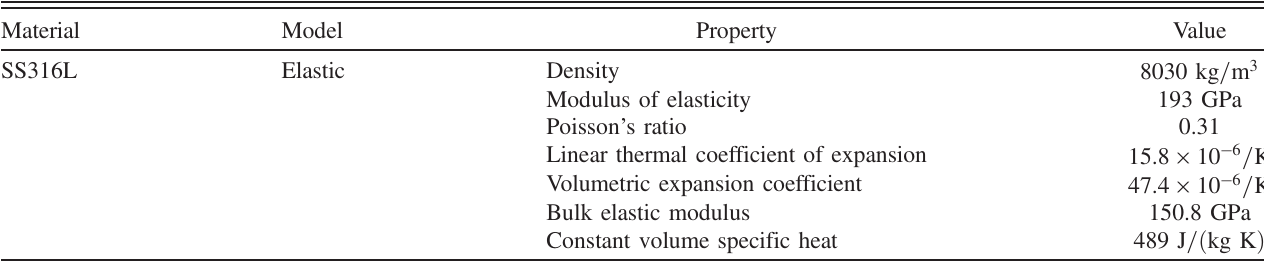
TABLE II. Vessel stainless steel material properties. Material